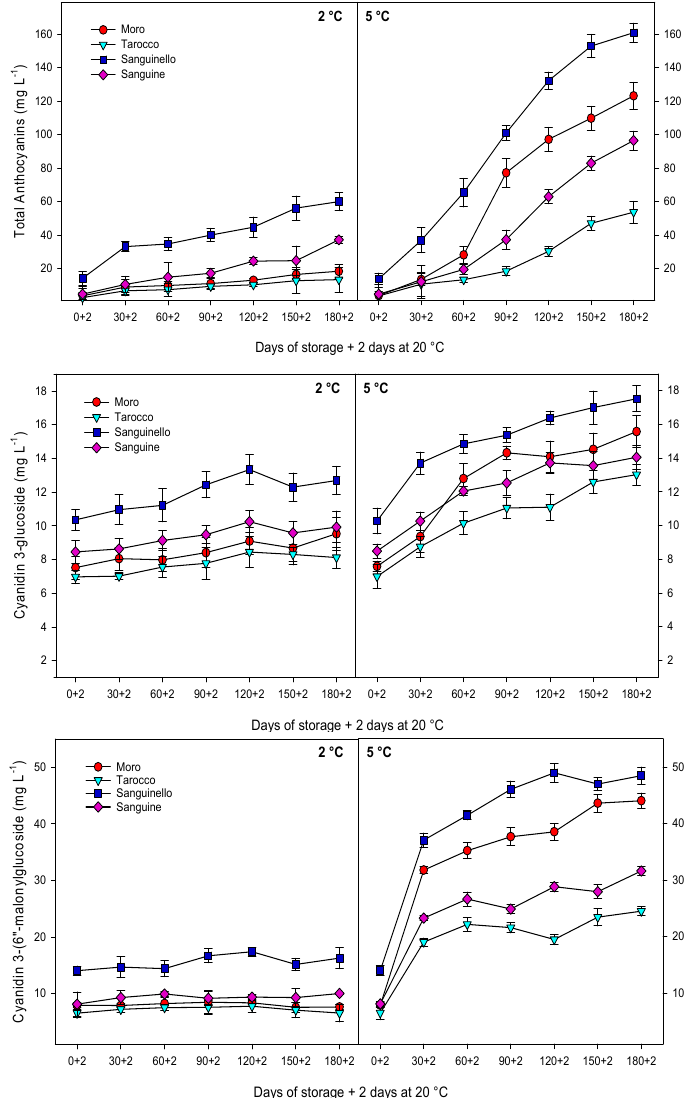
Figure 3. Changes in total anthocyanin concentration, cyanidin-3-glycoside, and cyanidin 3-(6 ″ -malonylglucoside) of blood orange cultivars (“Moro”, “Tarocco”, “Sanguinello”, and “Sanguine”) stored at 2 and 5 °C for 180 days plus 2 days at 20 °C. Vertical bars represent ± standard error (SE) of means. LSD ( p < 0.05) values are 3.2, 1.7, and 2.4, for total anthocyanin concentration, cyanidin-3-glycoside, and cyanidin 3-(6 ″ -malonylglucoside), respectively. Total phenolic content (TPC) was affected by cultivars, storage, and temperatures (Figure 4). TPC increased for all cultivars and then remained constant or decreased to the end of storage at both temperatures, the increase being enhanced at 5 °C (27% higher). Among cultivars, the highest and the lowest TPC were observed for “Sanguinello” and “Tarocco” with concentrations of 636 ± 24 and 368 ± 14 mg eq. of gallic acid L -1 , respectively, at the end of storage.